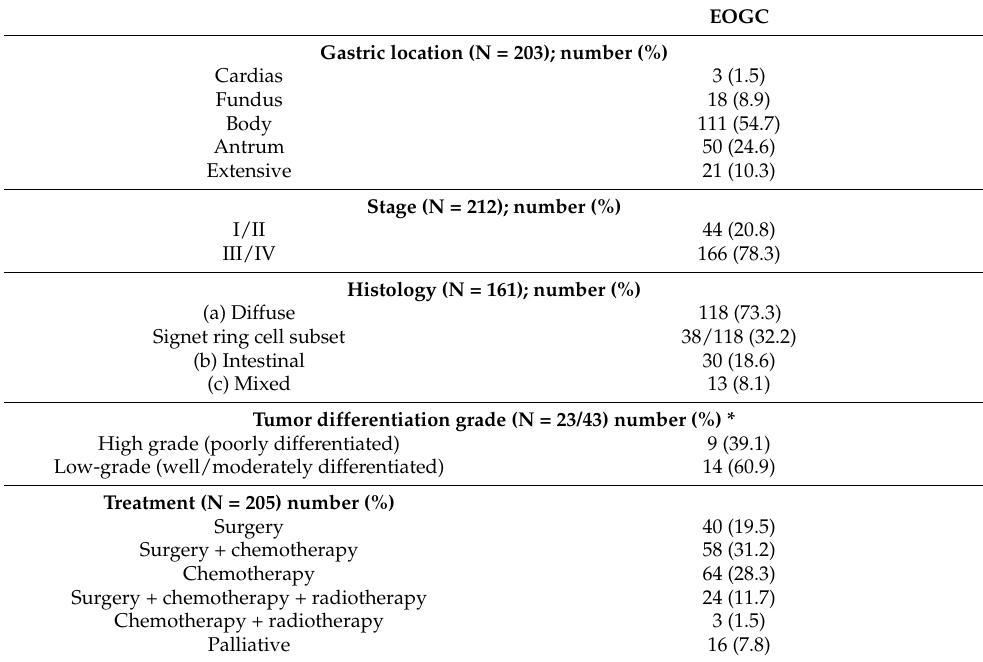
Figure 1. Immunohistochemistry of DNA mismatch repair proteins (MMR-IHC) in gastric cancer tissue loss of protein expression of MLH1 and PMS2, and normal protein expression of MSH2 and MSH6. Table 2. Characteristics of the tumors ( N = 309).